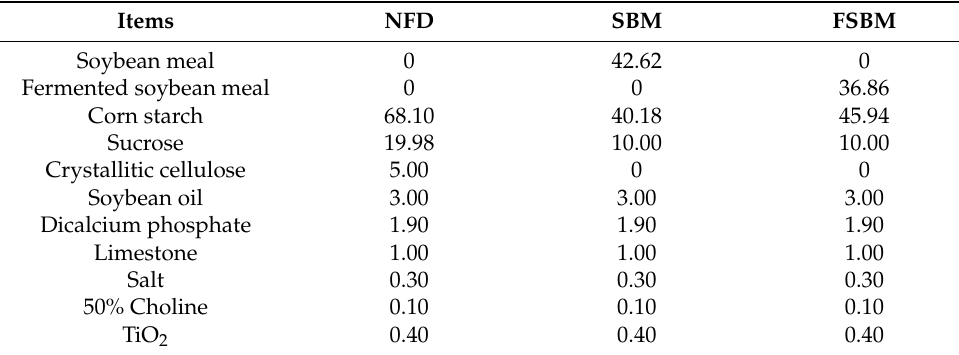
Table 2. Ingredient composition and nutrient levels of the nitrogen-free, soybean meal, and fermented soybean meal diets (air-dry basis,